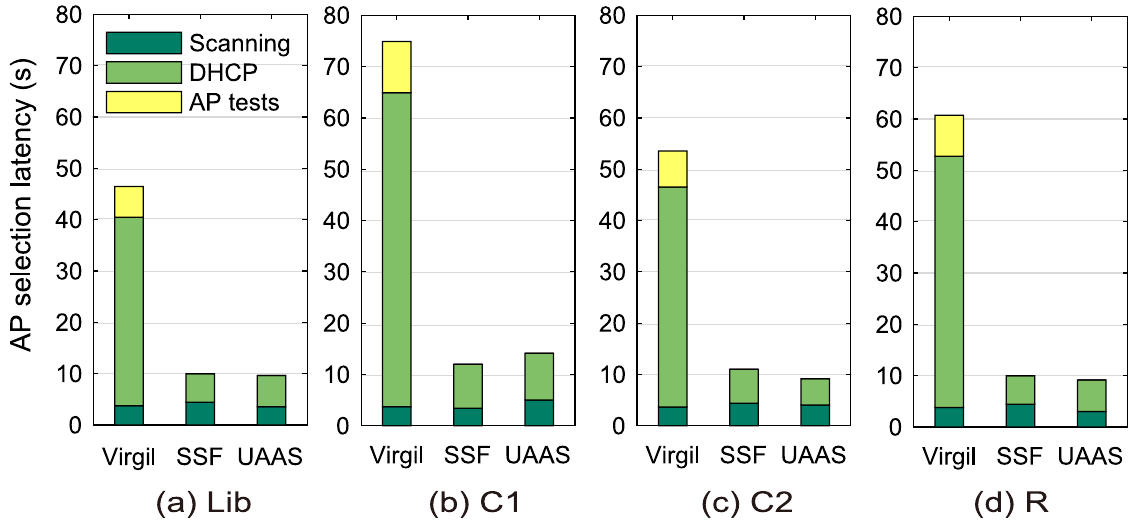
Fig 13. Average AP selection latencies of Virgil, SSF, and UAAS in Scenario 2. (a) at Lib, (b) at C1, (c) at C2, (d) at R.